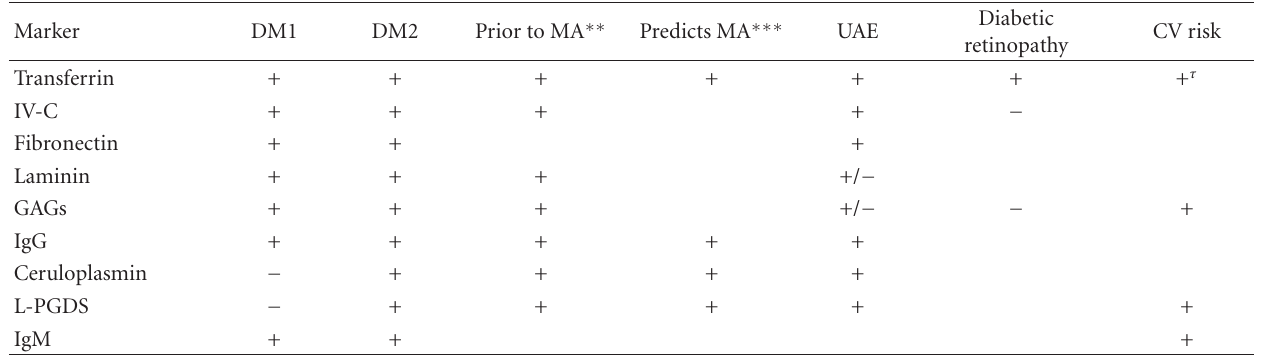
Table 1: Overview of biomarkers of glomerular injury in diabetic nephropathy ∗